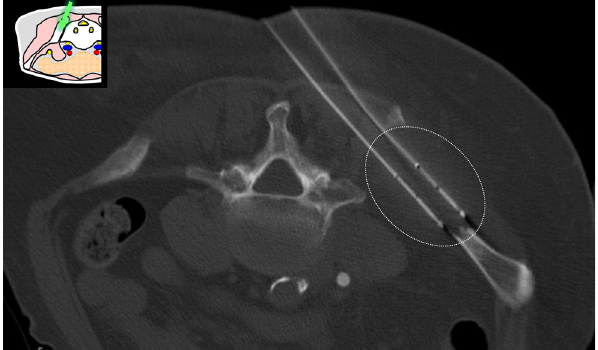
Fig. 21 A 65-year-old woman with lung cancer and painful iliac metas- tasis. Axial CT shows the cryoablation probes inserted along the greater axis of the iliac wing and the hypodense ice ball covering the lesion ( dotted line )